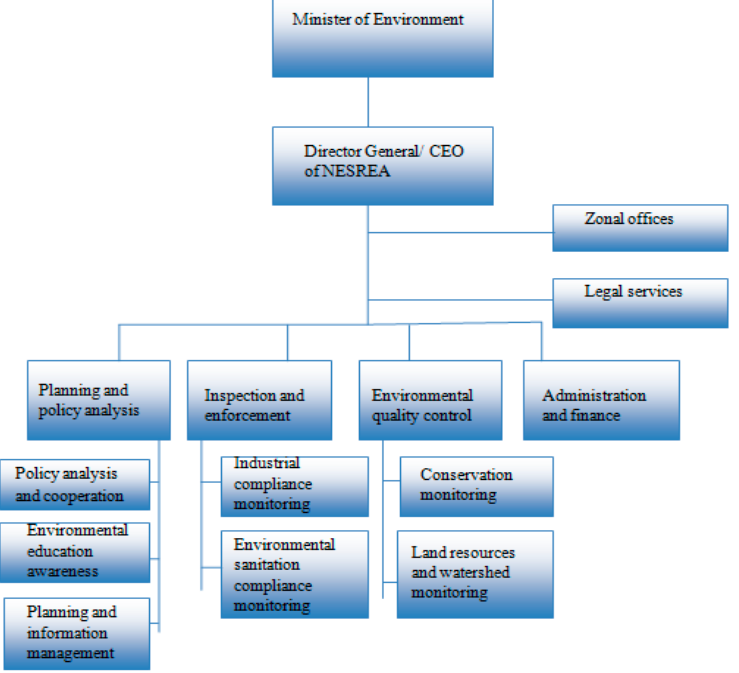
Figure 1. Organizational structure of the National Environmental Standards and Regulations Enforcement Agency (NESREA) (www.nesrea.gov.ng). CEO: Chief Executive Officer.